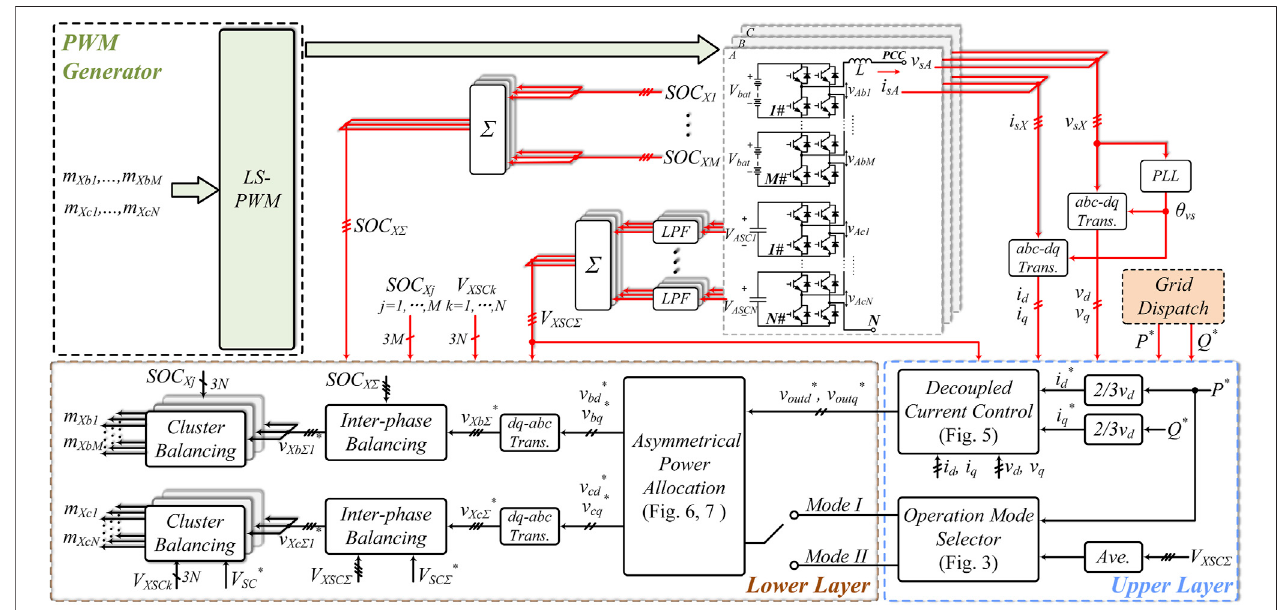
FIGURE 4 | Overall control block diagram.